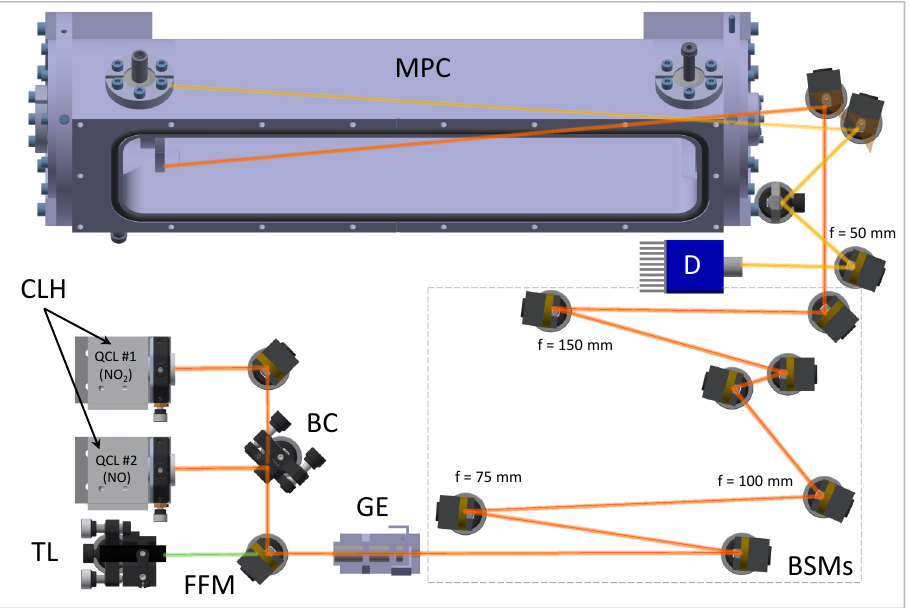
Figure 1. Top view of a 3D representation of the optical setup. Abbreviations: CLH, compact laser housing; BC, IR/IR beam combiner; TL, trace laser; FFM, flat flip-mirror; GE, germanium etalon; BSM, beam shaping in-coupling mirrors (f indicates the focal length of spherical mirrors); MPC, multipass cell (without closing lid); D, mid-infrared detector. The laser beam path from the CLHs to the first spot on the MPC’s back mirror and the path from the last spot to the detector are also indicated (colored